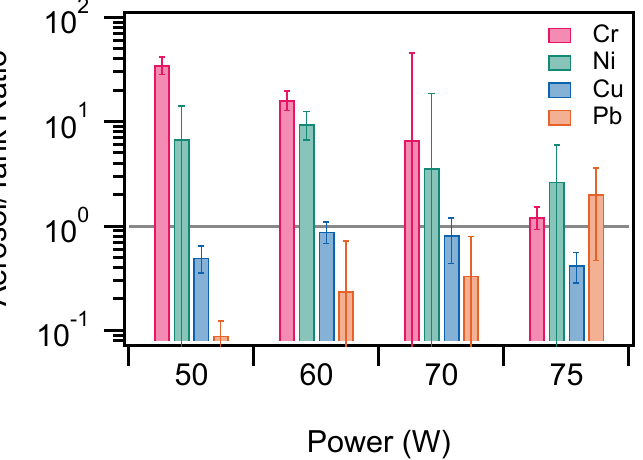
Figure 6. Mean aerosol/tank ratio plotted for each element and power. The gray horizontal line indicates an aerosol/tank ratio of one. The error bars represent the standard deviation of the mean aerosol/tank ratio over 10–40 puffs for each